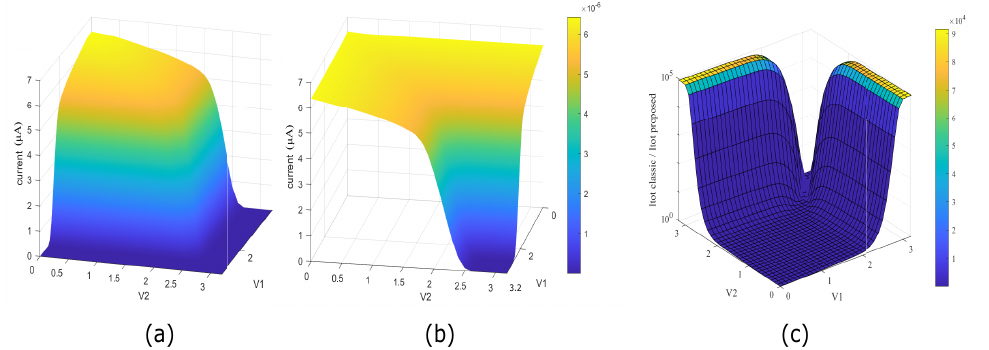
Figure 11. Total static current consumption for all the input voltage combinations for the proposed bump circuit ( a ) and the classic bump circuit ( b ). The ratio between the total static power consumption of the classic and the proposed power bump circuit is shown in ( c